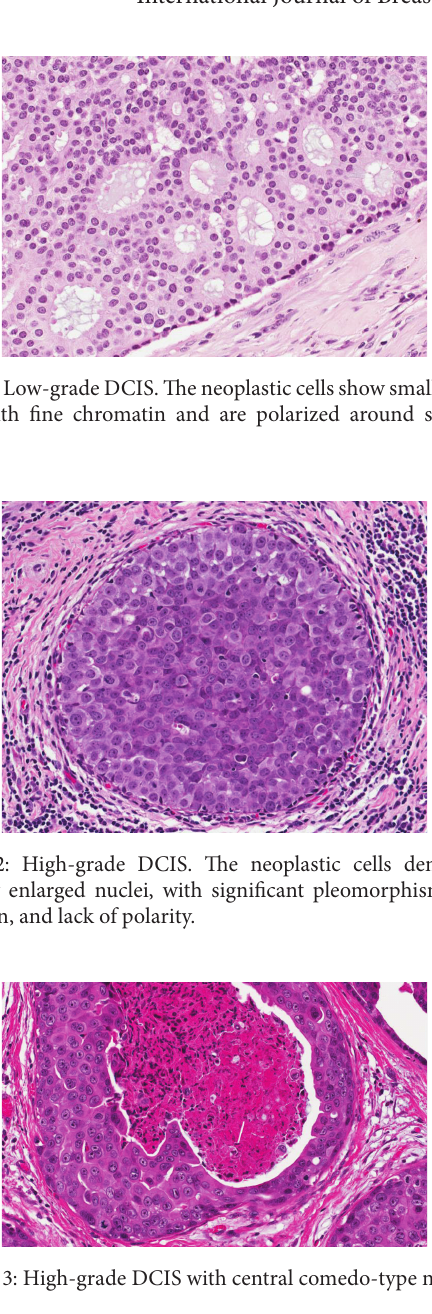
Two types of necrosis are